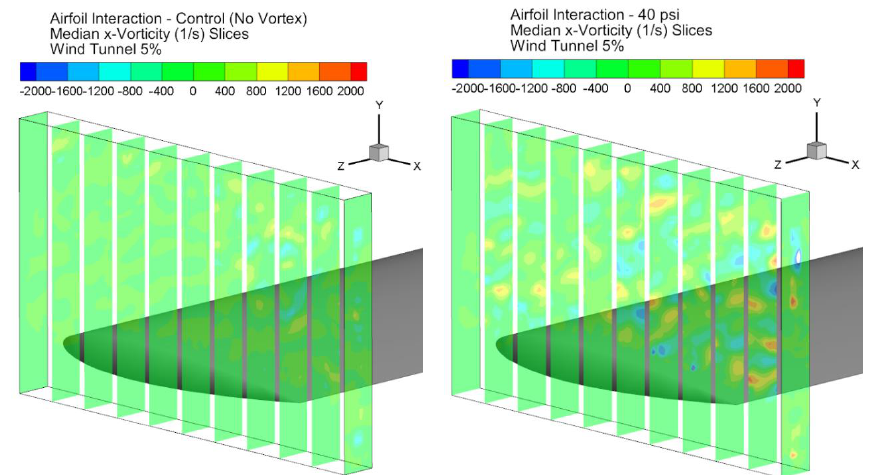
Figure 26. Airfoil interaction vorticity flow: instantaneous median frame of x-vorticity maps for control (no vortex tube) and vortex generator set at 40 psi; translucent view to allow airfoil view.